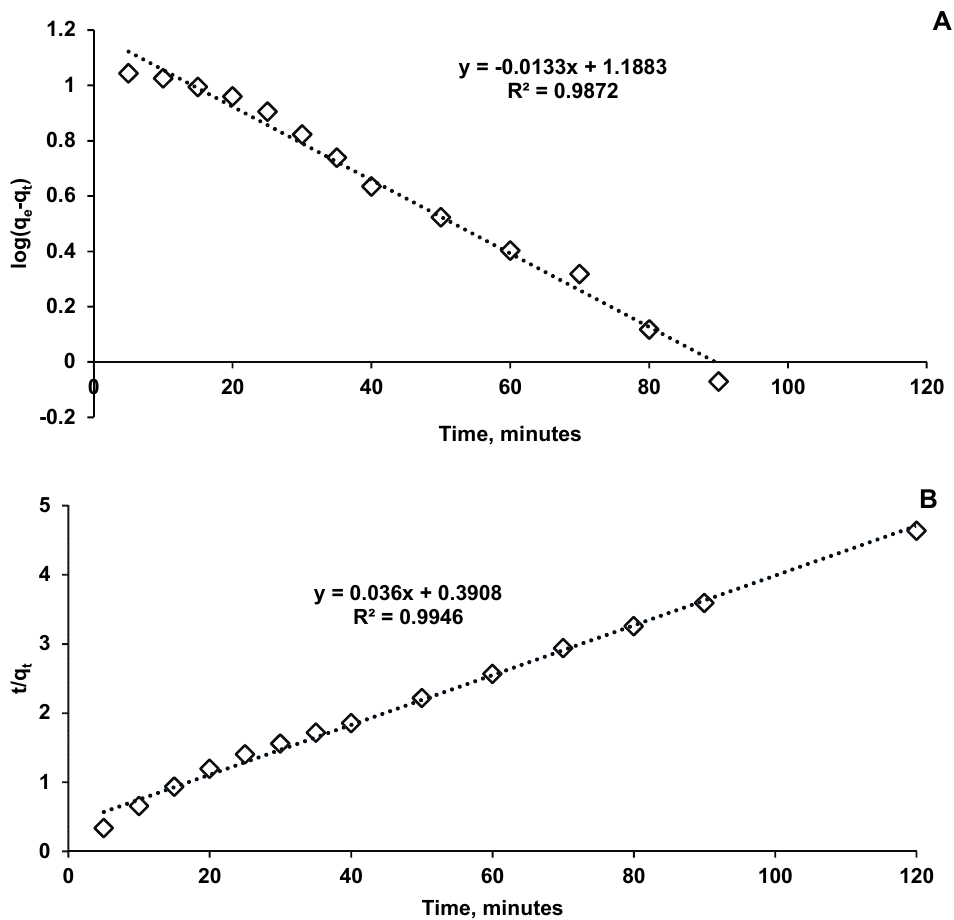
Figure 10. Pseudo–first-order ( A ) and pseudo–second-order ( B ) kinetics models of CPX biosorp- tion process.